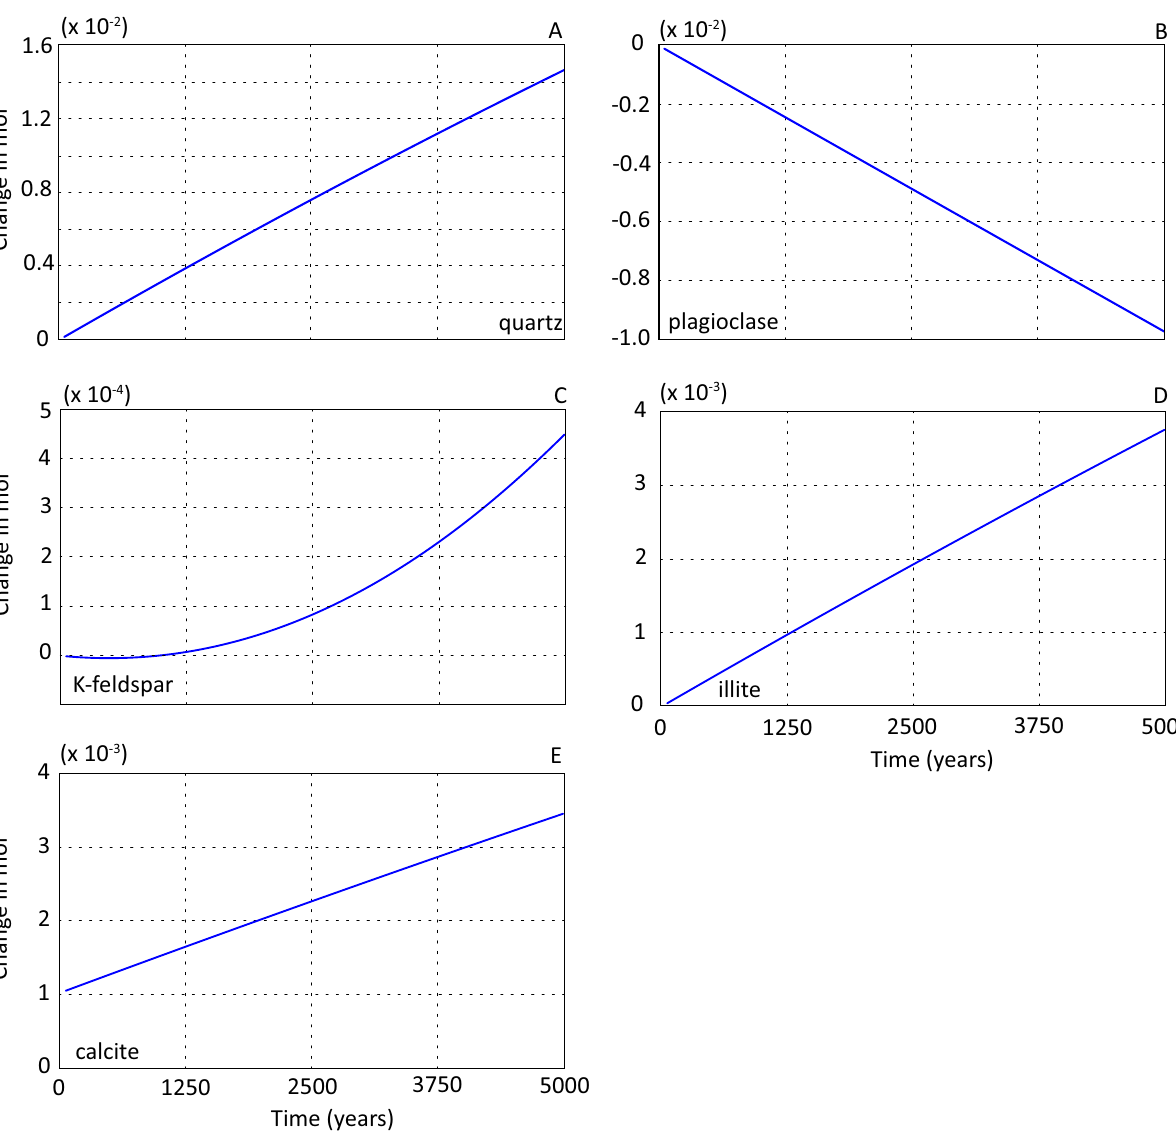
Figure 2. Temporal development of mineral abundances for primary ( A – C ) and secondary ( D – E ) minerals presented for cell #31 over the simulated period for scenario 1. All results are displayed as change in moles from the starting